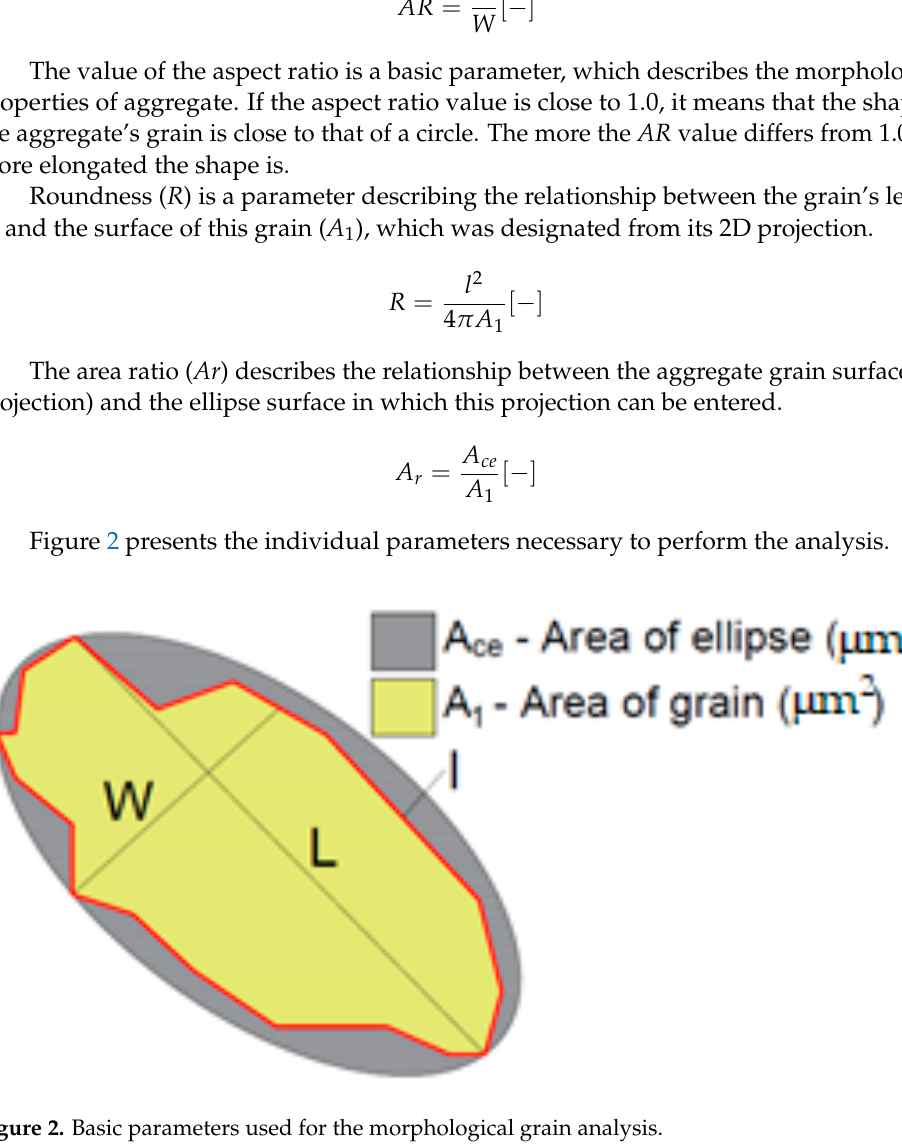
Figure 2. Basic parameters used for the morphological grain analysis.